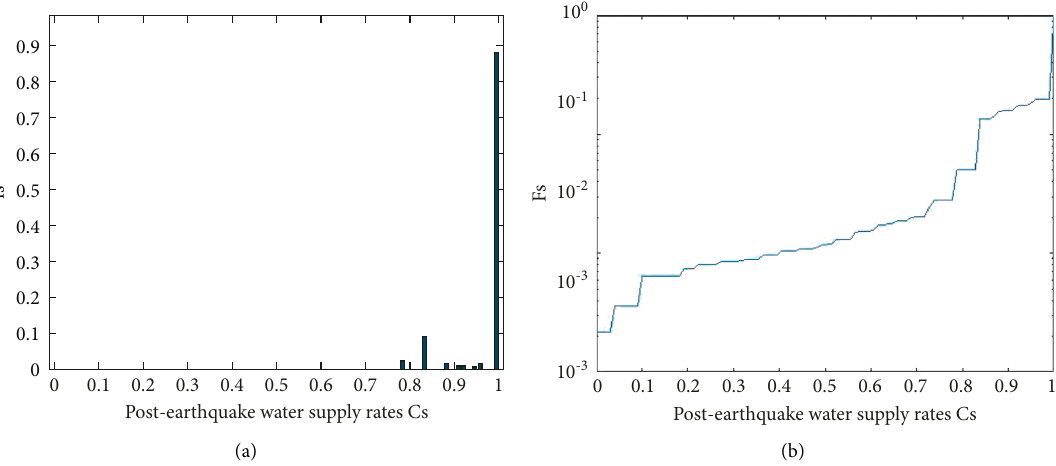
Figure 4: Post-earthquake water supply rate (cast iron pipe) with no liquefaction of intensity VIII. (a) Probability mass function. (b) Cumulative distribution